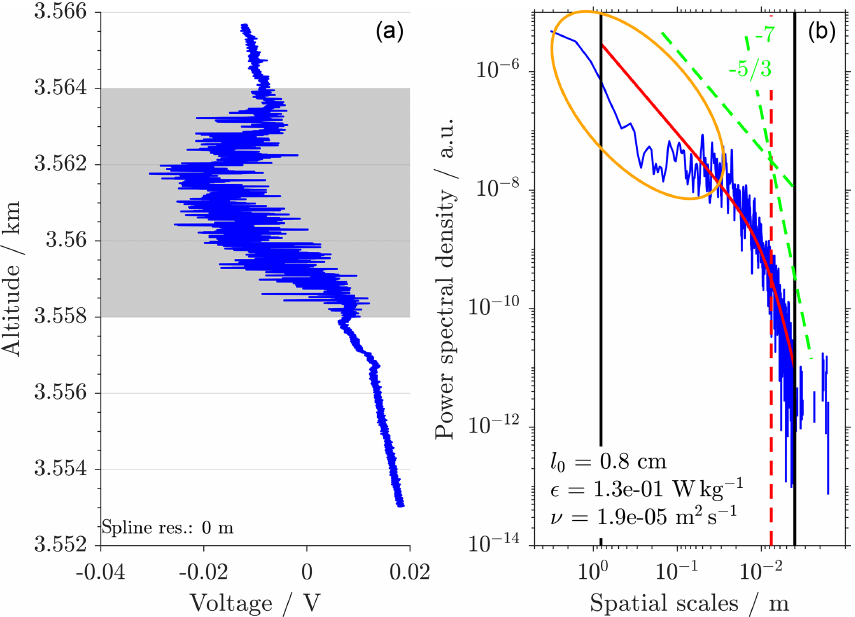
Figure 9. Wake of a rope holding the gondola. (a) Raw data from the CTA. (b) Turbulence retrieval fit as in Fig. 1 from the data shown in (a) . The orange ellipse denotes a region of reduced power spectral densities compared to the Heisenberg model (Eq. 1). This points to turbulence in the wake of a small object in the vicinity of the